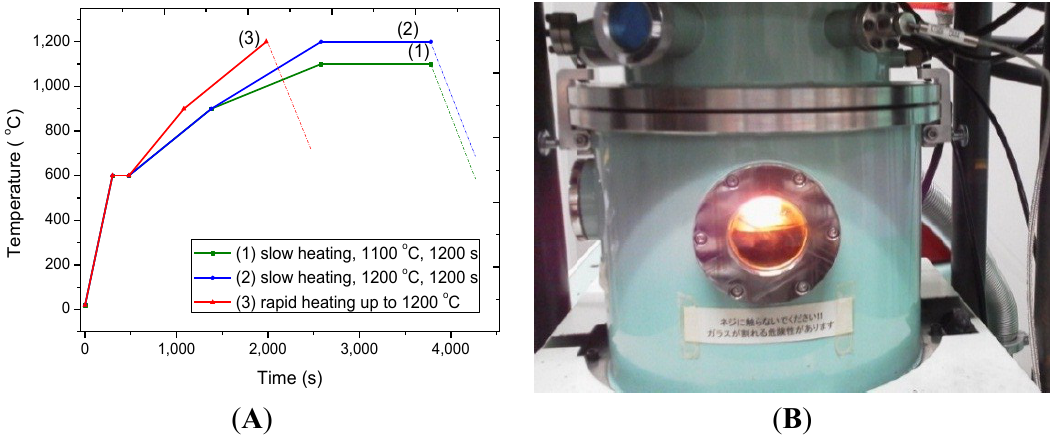
Figure 9. ( A ) Graph representing the thermal history (heating program) sintering of TiB 2 -Cu cermets by Spark Plasma Sintering (SPS); ( B ) SPS